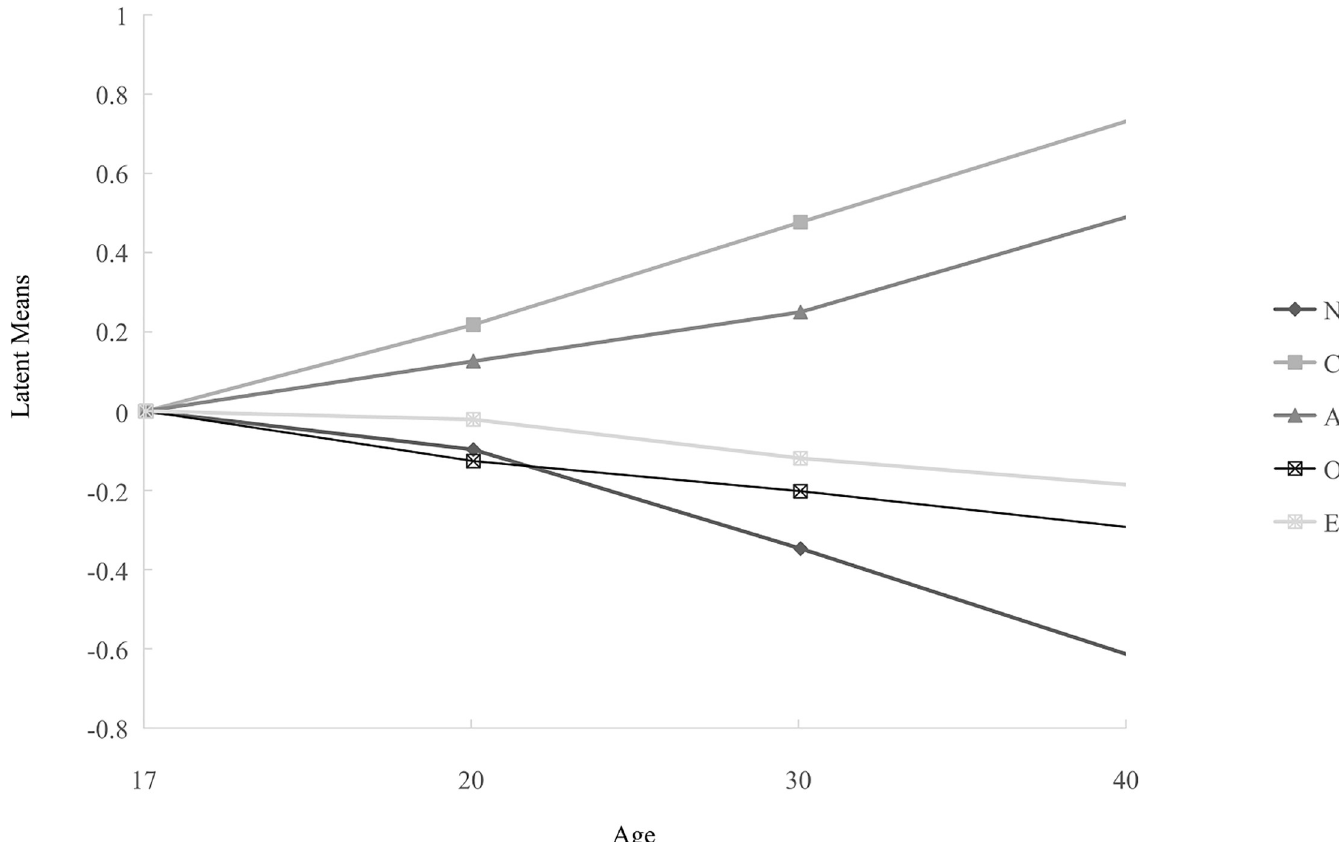
Fig 2. Latent means of males’ Big Five dimensions results across different age